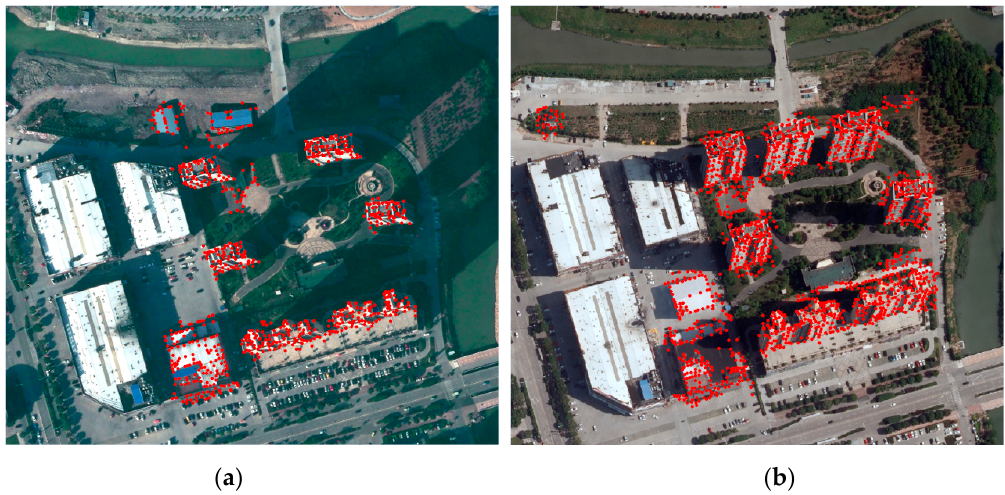
Figure 7. Feature detection. ( a ) Feature points detected in building change proposals at times t 1 and ( b ) t 2